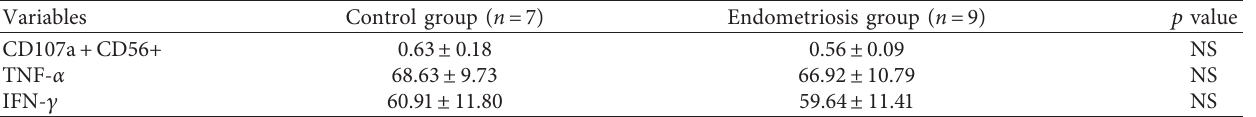
Table 2: Comparison of surface markers and intracellular cytokines between the endometriosis and control groups. Variables